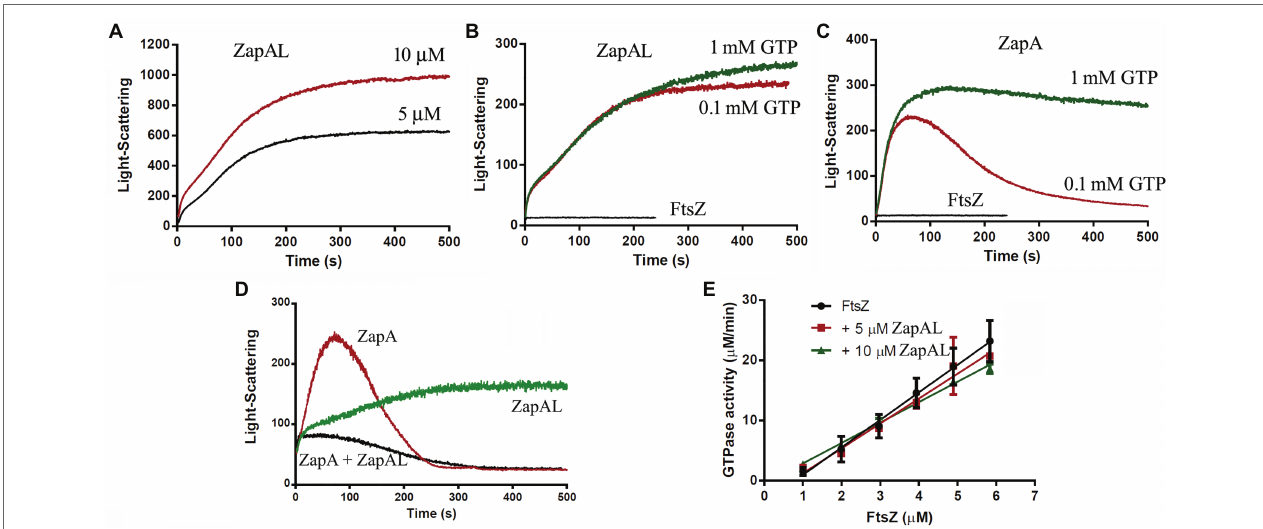
FIGURE 3 | Kinetics of FtsZ assembly in the presence of or in the absence of ZapAL or ZapA followed by light scattering. (A) shows the bundles formation of 5 μ M FtsZ-ZapAL and 10 μ M FtsZ-ZapAL in HMK buffer measured by light scattering assay. (B,C) show the comparison of the assembly kinetics of 10 μ M FtsZ-ZapAL (B) or 10 μ M FtsZ-ZapA (C) in the presence of 1 mM and 0.1 mM GTP. (D) shows the comparison of the assembly kinetics of 10 μ M FtsZ with 10 μ M ZapAL, 10 μ M ZapA, and the mixture of 5 μ M ZapAL and 5 μ M ZapA in the presence of 0.1 mM GTP. (E) shows the comparison of the GTPase activity of FtsZ, FtsZ with 5 μ M ZapAL and FtsZ with 10 μ M ZapAL at room temperature. Error bars show the SD of three